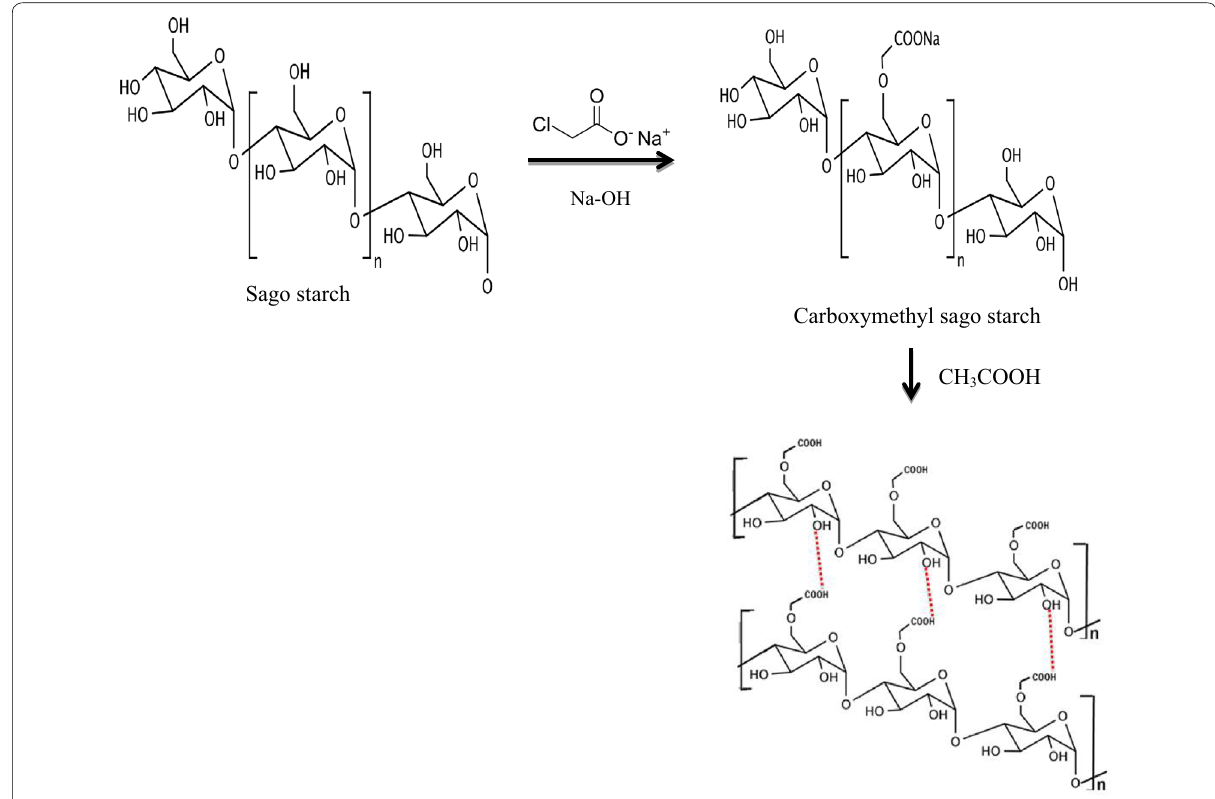
Fig. 2 Diagrammatic scheme of sago starch, CMSS and CMSS–acid